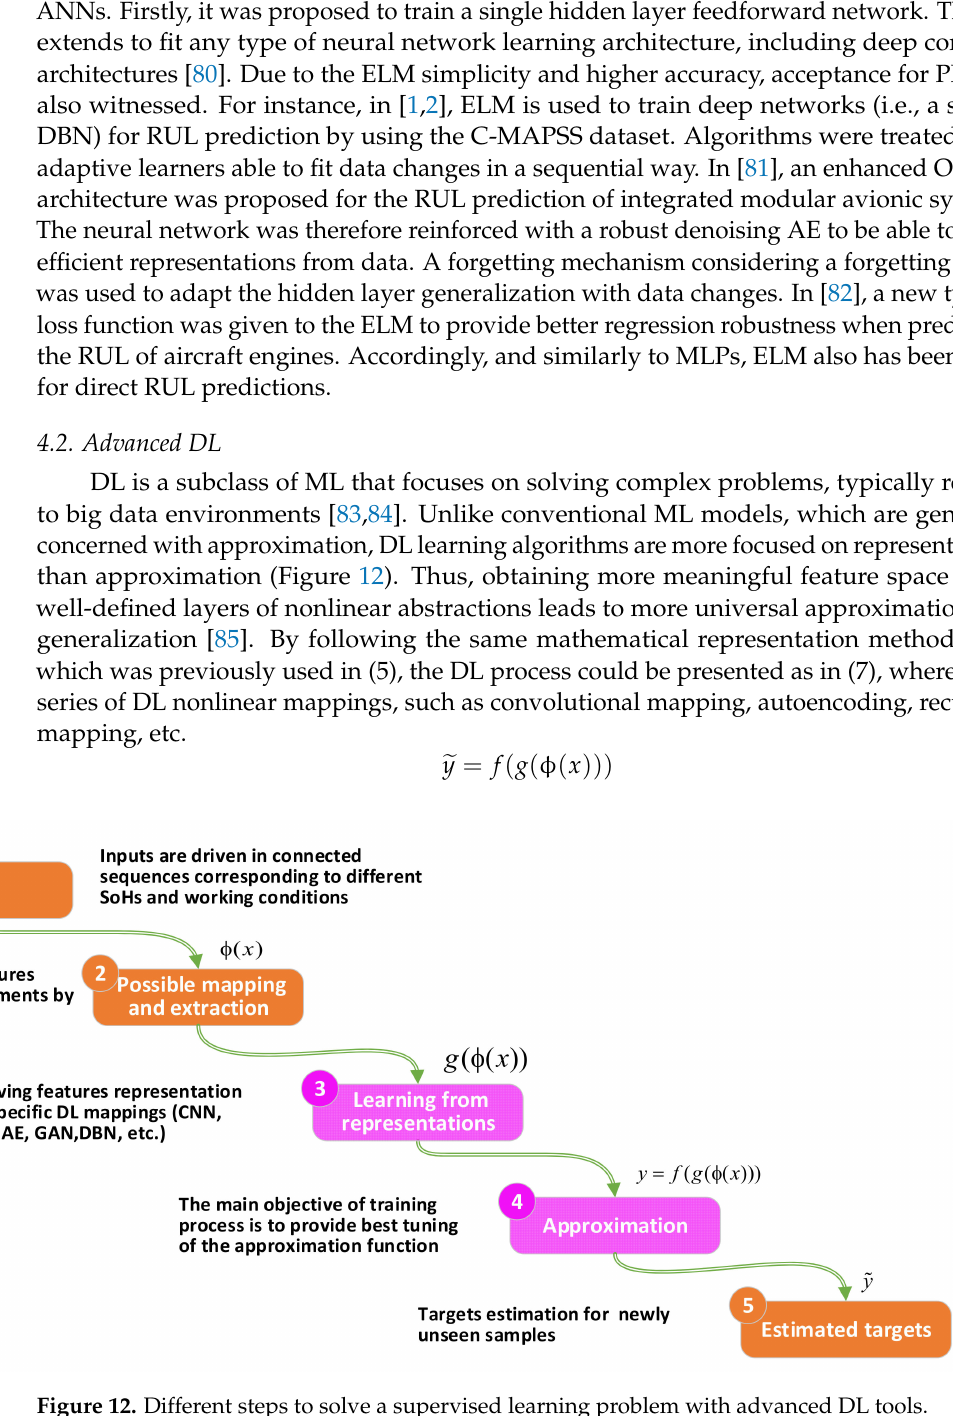
Figure 12. Different steps to solve a supervised learning problem with advanced DL